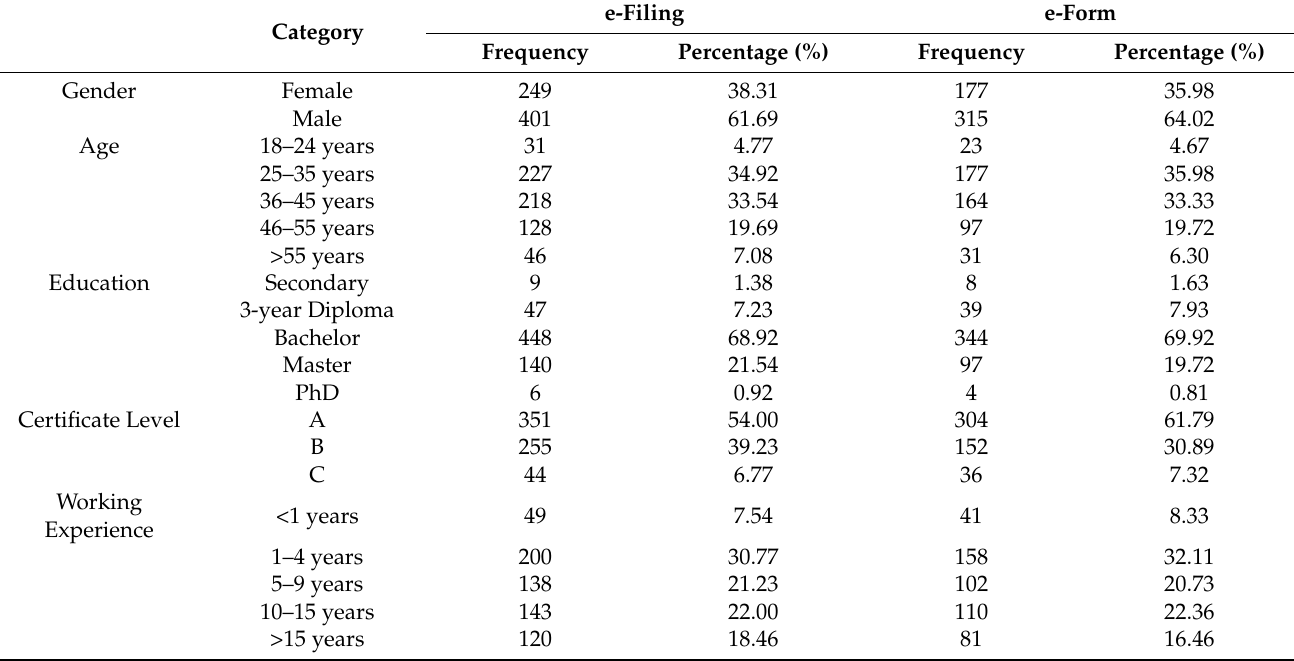
Table 1. Characteristics of the